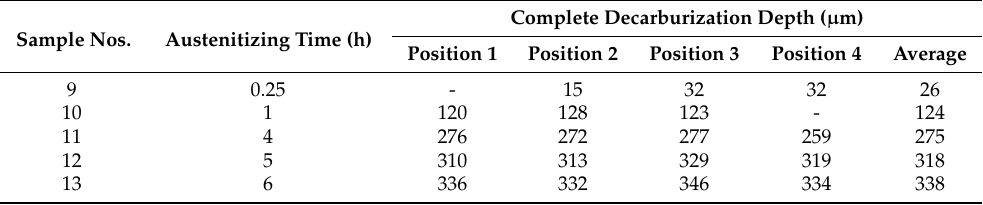
Table 3. Complete decarburization depths estimated based on metallographic analysis of all samples with pearlitic core microstructure.